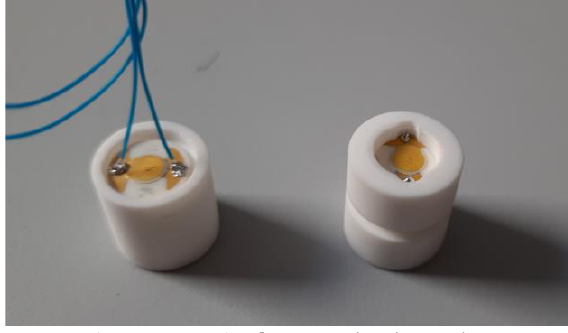
Figure 8 : Acoustics elements ready to be tested